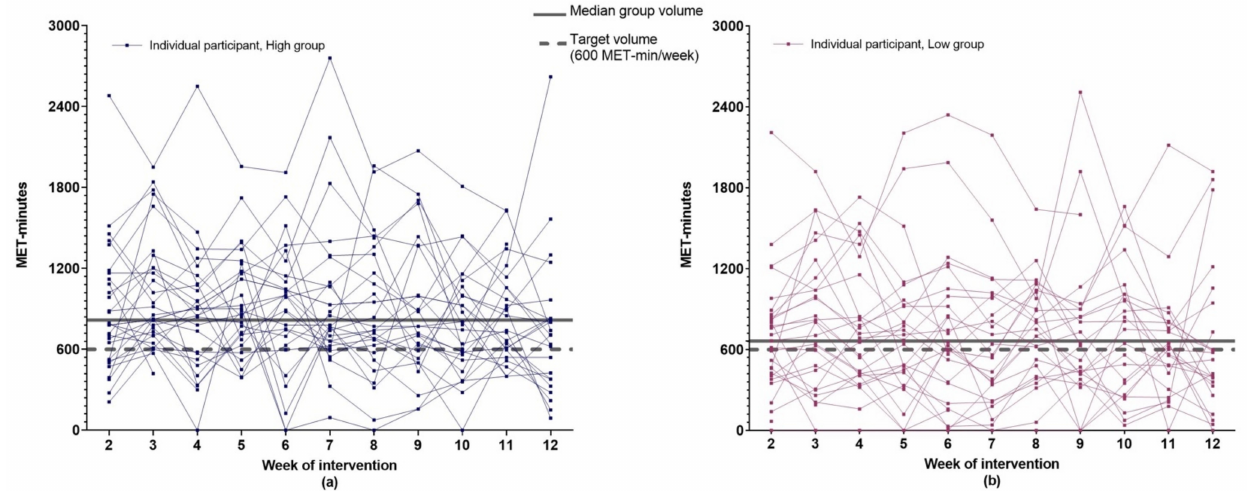
Figure 3. Weekly exercise volume over the 12-week intervention for each participant. ( a ) Data from participants in the high-supervision group; ( b ) Data from participants in the low-supervision